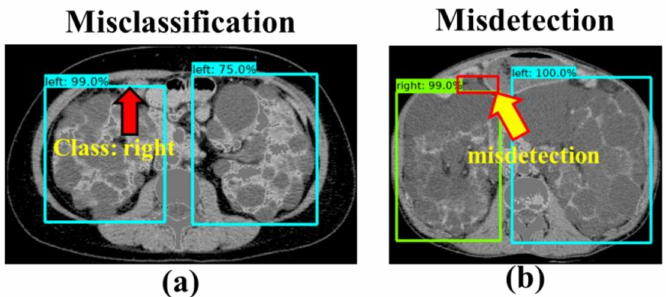
Figure 12. Misclassification and misdetection example: ( a ) Misclassification; ( b )